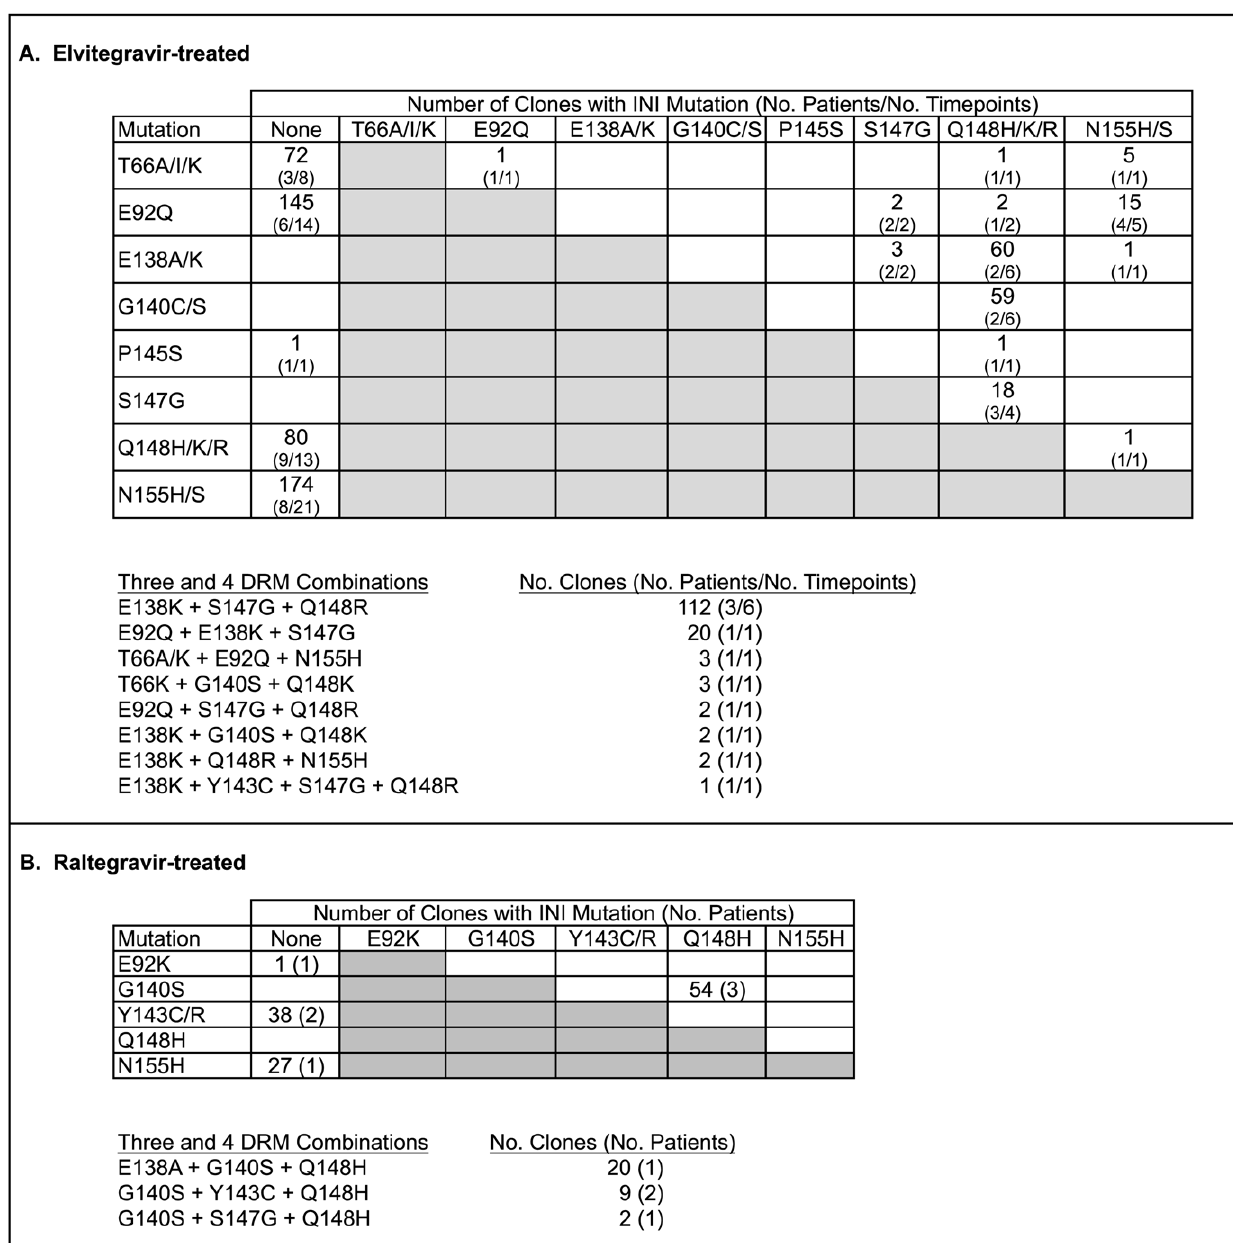
Figure 3. Frequency of INI DRM found in HIV-1 strains from patients treated with elvitegravir (A) or raltegravir (B). Occurrence of clones with single INI DRM are shown in the ‘‘none’’ column, and clones with two INI DRM are shown in the white cells. Strains with 3 or 4 INI DRM are shown in the bottom of each panel.